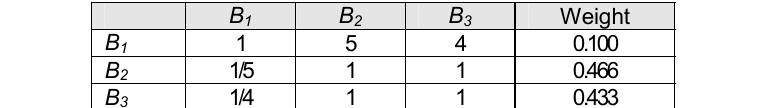
Table 12 – Matrix of the relevant importance of alternatives in relation to attribute A 7 (Sustainability) Таблица 12 – Матрица релевантной значимости альтернатив по отношению к атрибуту A